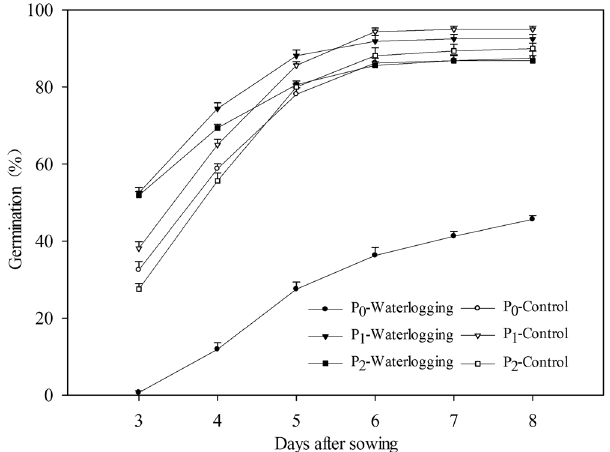
Figure 3. Germination dynamics of pelleted rice seeds in two pelleting treatments under waterlogging (1.5 cm water layer) and normal conditions (without water layer) in Experiment 3. P 0 : non-pelleted naked seeds; P 1 : Seed pelleting time of three with CaO 2 content of 20% in formula 1; P 2 : Seed pelleting time of three with CaO 2 content of 20% in formula 2. The seed germination data were recorded from 3 DAS until constant at 8 DAS. Error bars indicate standard error (n = 4).